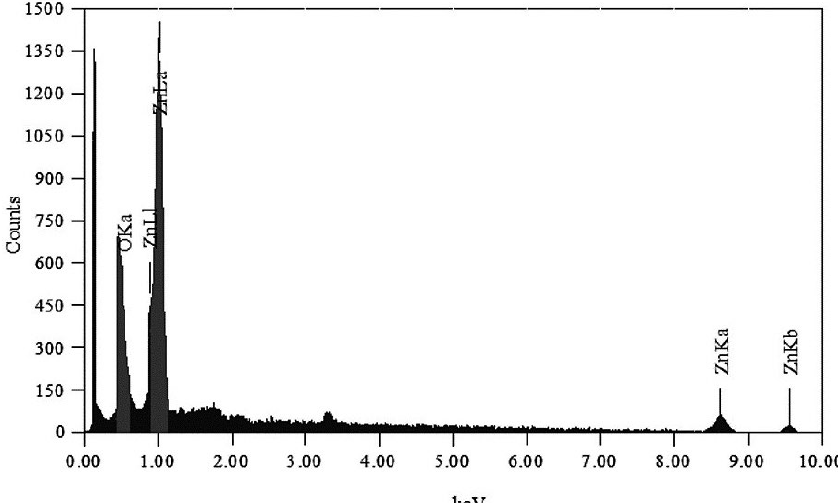
Figure 4. EDX pattern of ZnO NPs